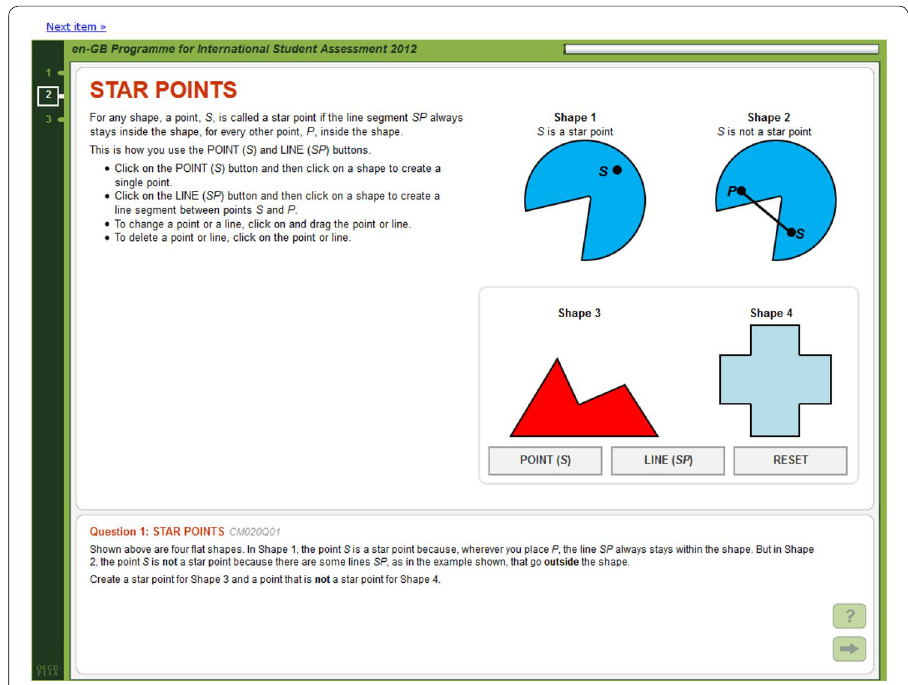
Fig. 6 Example item Star Points part